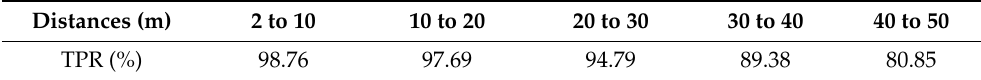
Table 2. Clustering detection results.